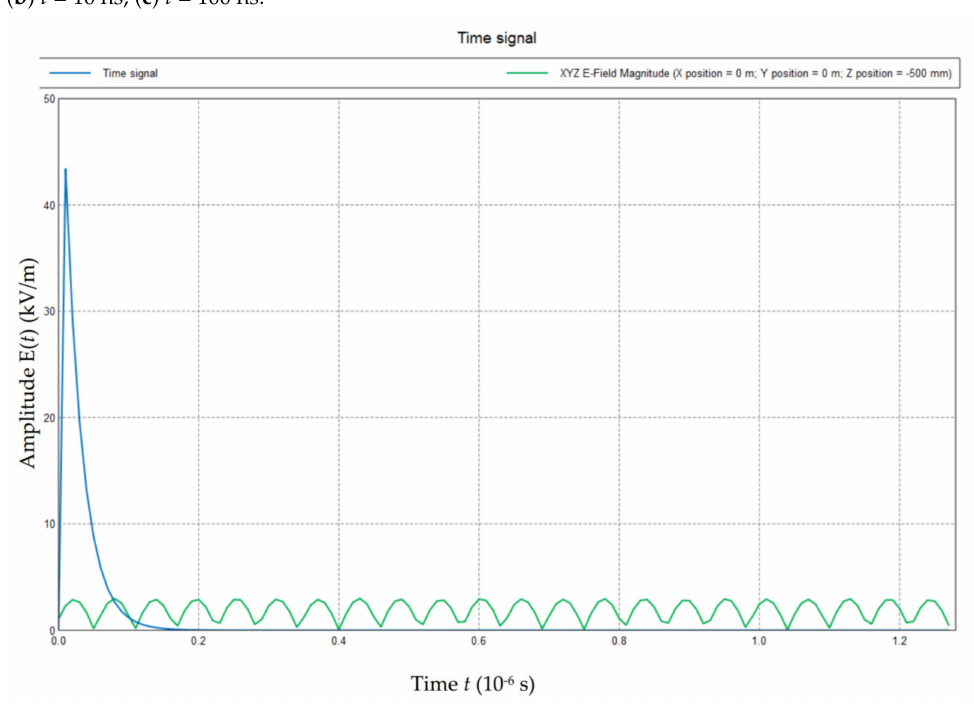
Figure 11. Tendencies of the electric field strength E ( t ) of various positions of inner layer inside the